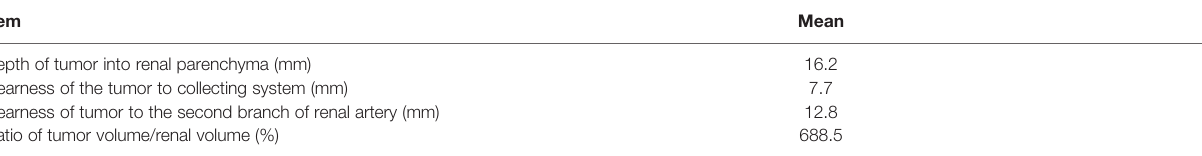
Table 4 shows a subgroup analysis of eight and six PN patients in 3D and control groups, respectively. No statistically signi fi cant difference was found between these two subgroups, except for postoperative change in hemoglobin. However, patients with 3D- assisted PN had a slightly larger tumor (18.1 ± 2.3 vs . 16.9 ± 2.5 contributing to a relatively higher rate of complications (75.0% vs .